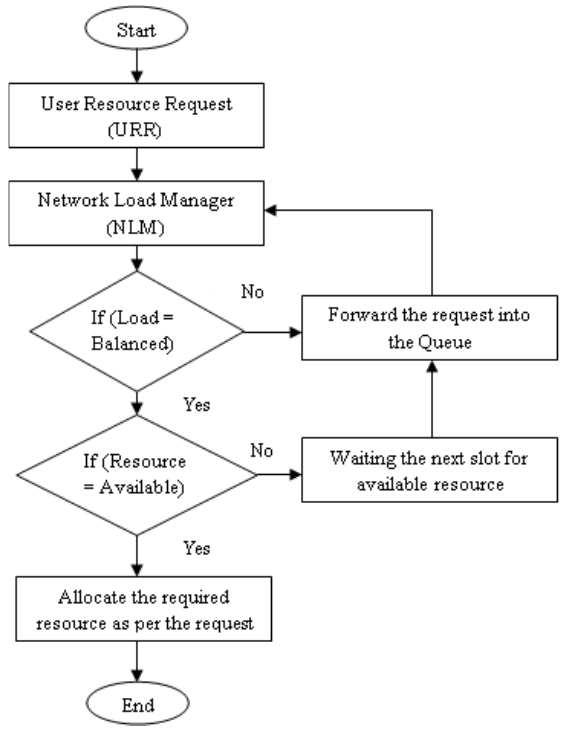
Figure 2. Proposed flow diagram .